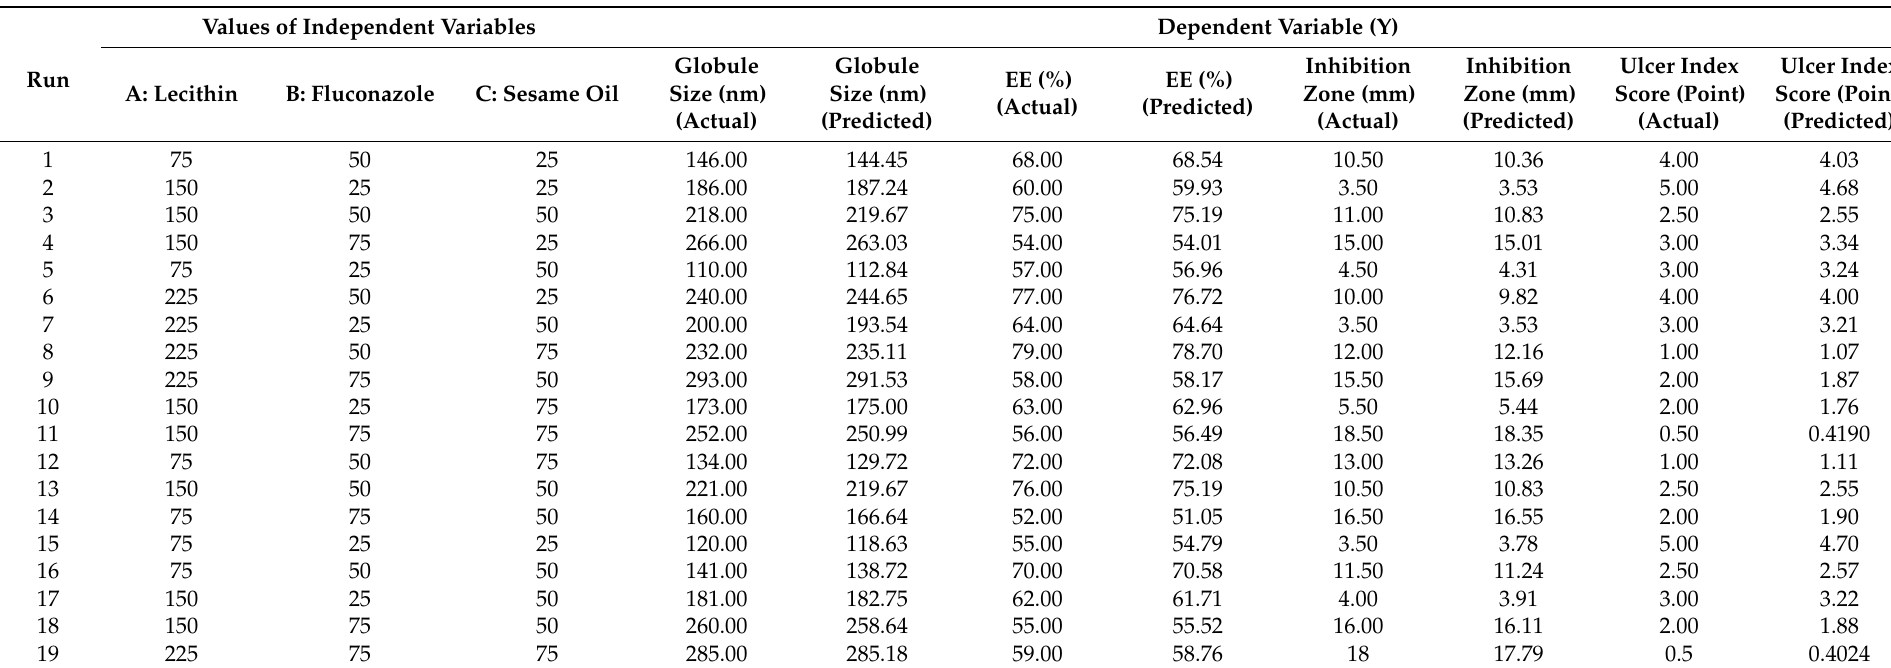
Table 1. Experimental runs in Box–Behnken statistical design: The independent variables and experimental dependent